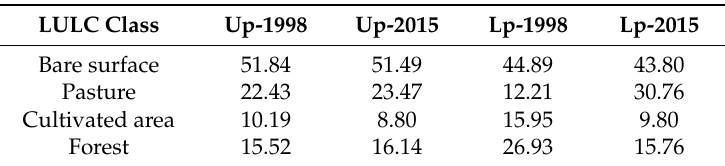
Table 5. Metrics comparison and changes in PLAND at land cover class level for 1998 and 2015 in the upper part (up) and lower part (lp) of HSCZ.